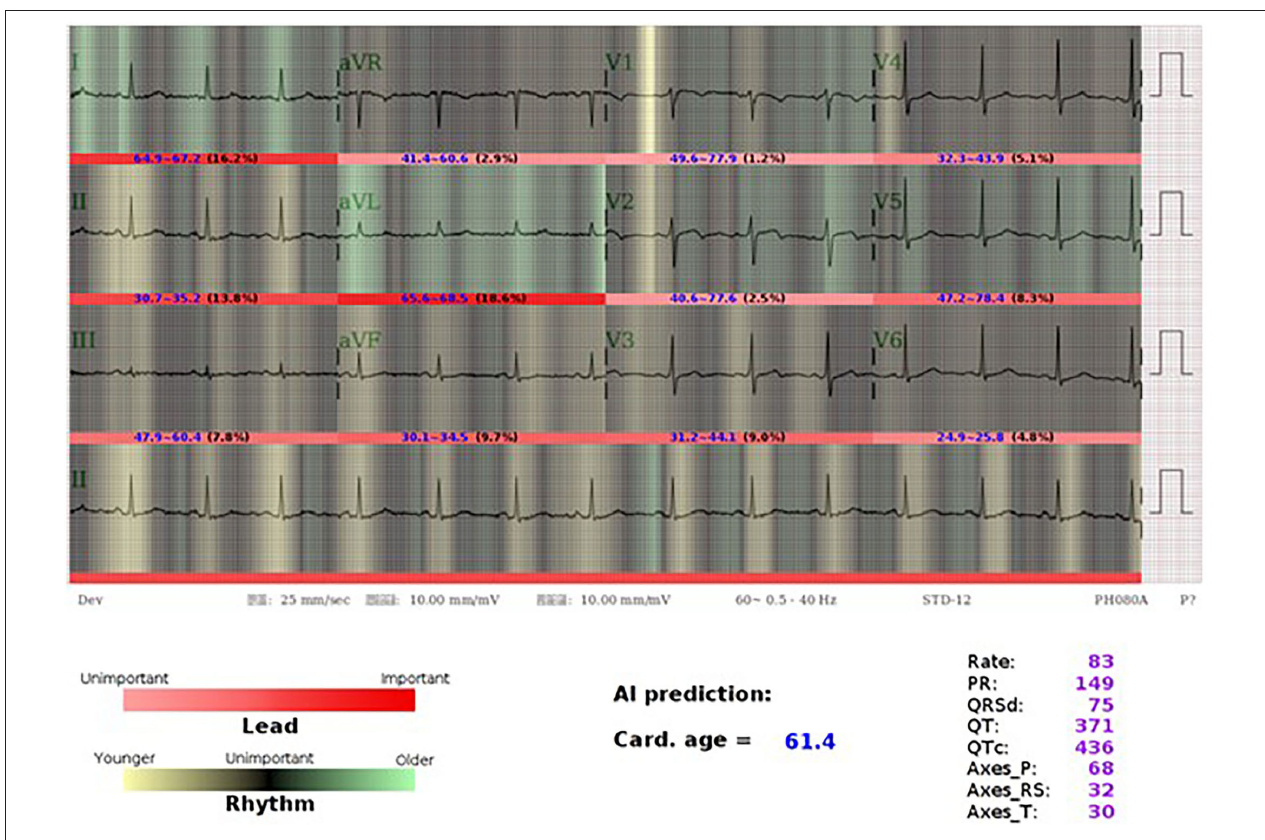
FIGURE 6 | AI-ECG visualization of a 46-year old female with older ECG-age. A 46-year-old woman who had type 2 diabetes mellitus, hyperlipidemia under regular OPD follow up. Her ECG-age is 61.4 years old which is much higher than her chronological age. Using the class activation mapping and attention mechanism to explain the AI-ECG prediction, we used white-to-red gradient to indicate the importance of each lead, and the darker-to-light gradient to indicate the contribution of each position in prediction of ECG-age. Light green and yellow mean older and younger rhythms. The most important part in this case is aVL, which accounts for 18.6%, while AI considered it was an old feature with widely green color. Although it presents sinus rhythm, we can see the part emphasized by AI-ECG shows relative irregular baseline, which may be caused by a patient with muscle tremor, muscle tension, dry skin turgor, and Parkinson’s disease. We considered that AI-ECG may acquire information from these tiny changes. The patient was diagnosed of coronary artery disease, single vessel disease status has post-percutaneous coronary intervention with a drug-eluting stent implanted at left circumflex artery after 3